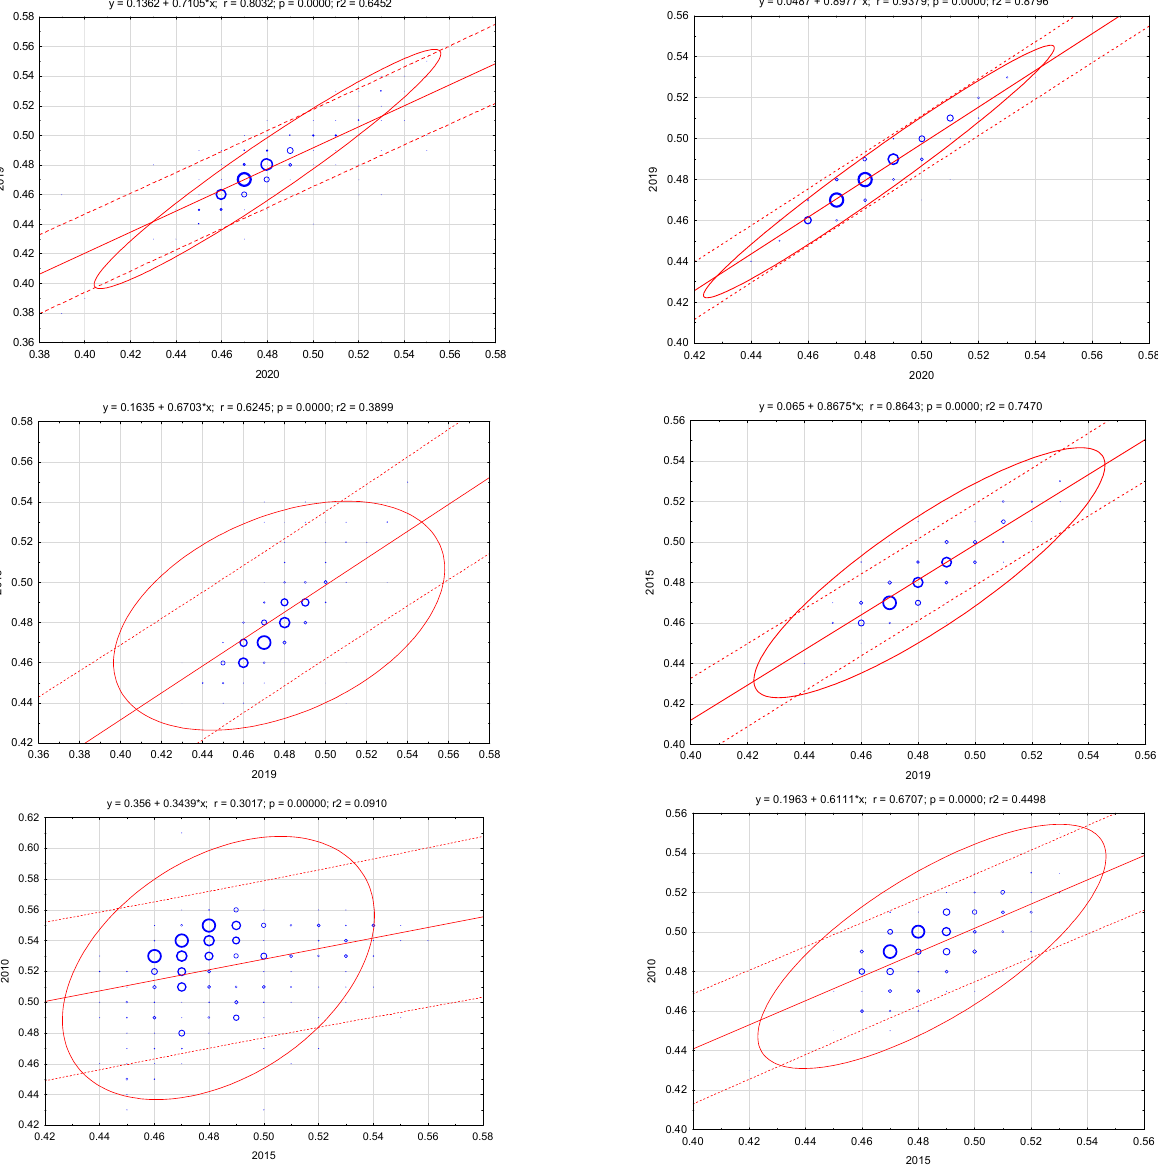
Figure 5. Diversity (spread) of the synthetic measure, waste management and green economy in districts in Poland (in 2010, 2015, 2019, and 2020). Source: Own study. The Pearson correlation coefficient between the value of the measures analyzed in subsequent years was 0.473 and 0.474 for 2010 and 2020, respectively. The pocket graph shows statistically similar clusters of districts (including outliers, whose graphical form in the later years 2010 and 2015 as well as 2019 and 2020 indicate their slight differentiation) (Figure 6).